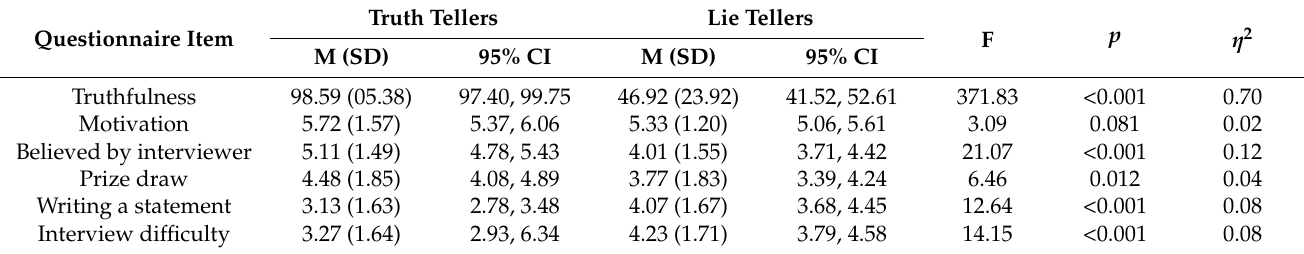
Table 1. Descriptive and Inferential Statistics for the Ratings in the Post-Interview